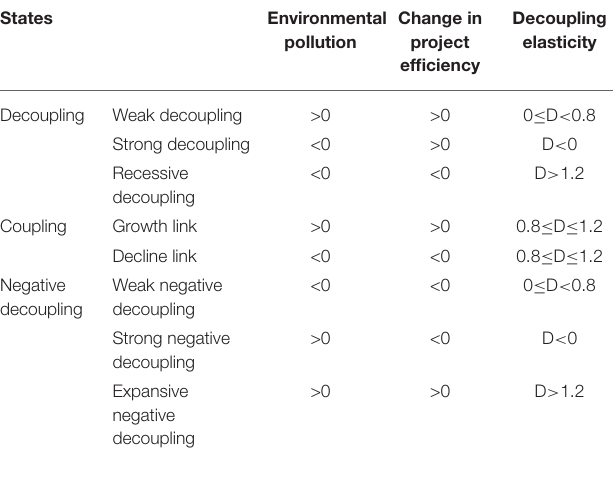
TABLE 4 | Decoupling elasticity and states.